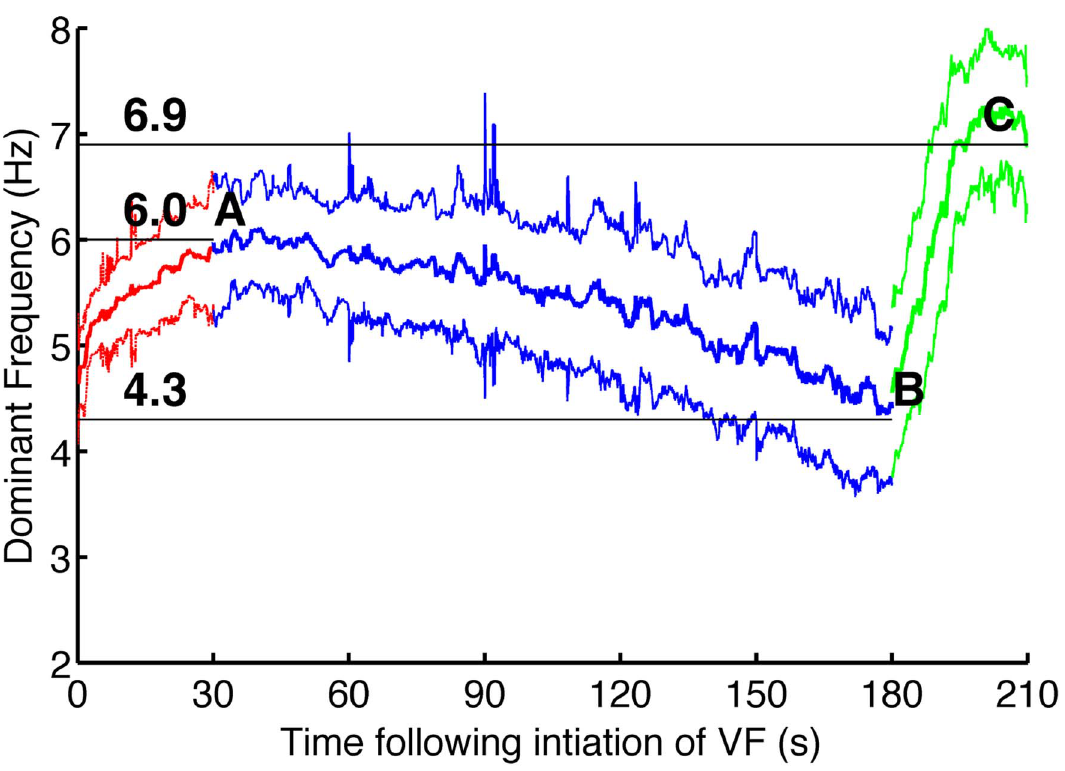
Figure 6. Change of DF over time for one patient (H066). Red denotes DF recorded with the heart perfused, blue denotes ischemia, and green reflow. The middle line shows mean DF, averaged over electrodes, and the top and the bottom lines show one standard deviation either side of the mean.